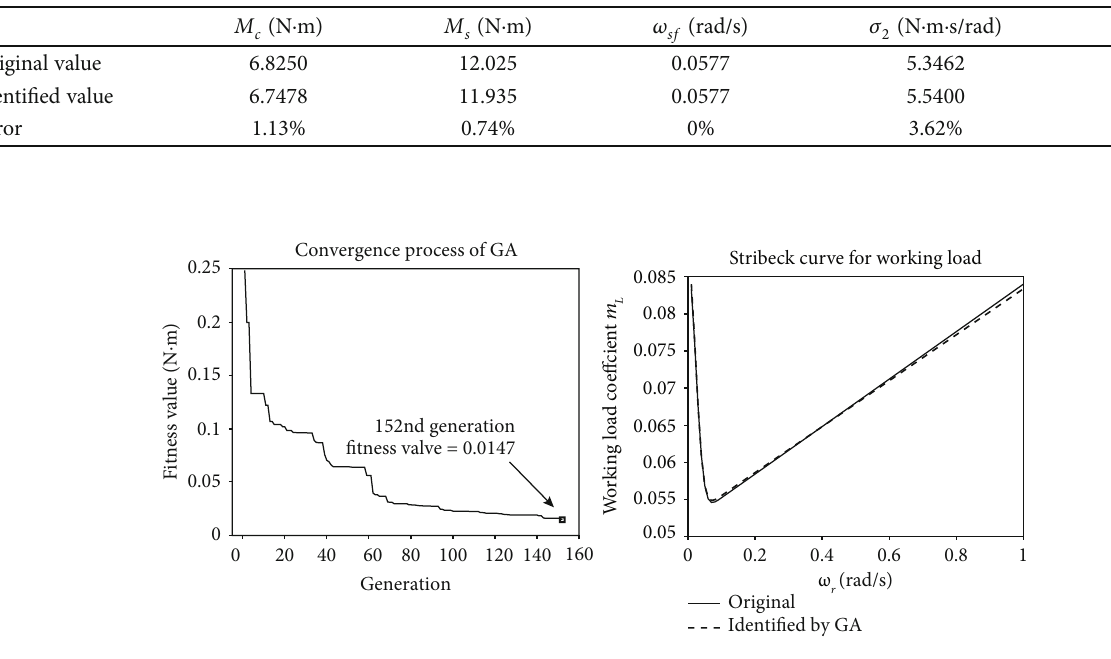
Figure 13: Parameter identi fi cation result of the working load model using a genetic algorithm.